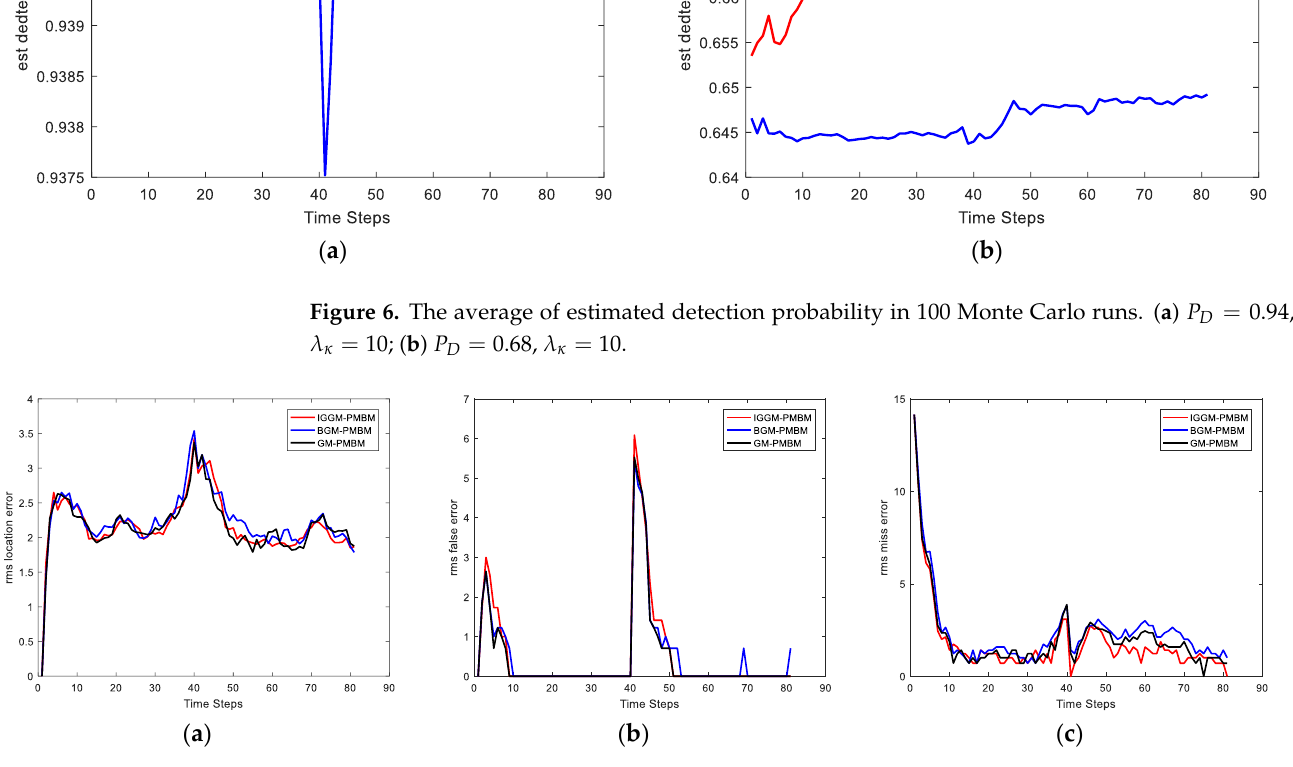
Figure 7. Comparisons of ( a ) location error, ( b ) miss error and ( c ) false error with P D = 0.68, λ κ = 10. Table 2. Root mean square GOSPA and LE, ME, and FE at all time steps with different parameters ( P D , λ κ